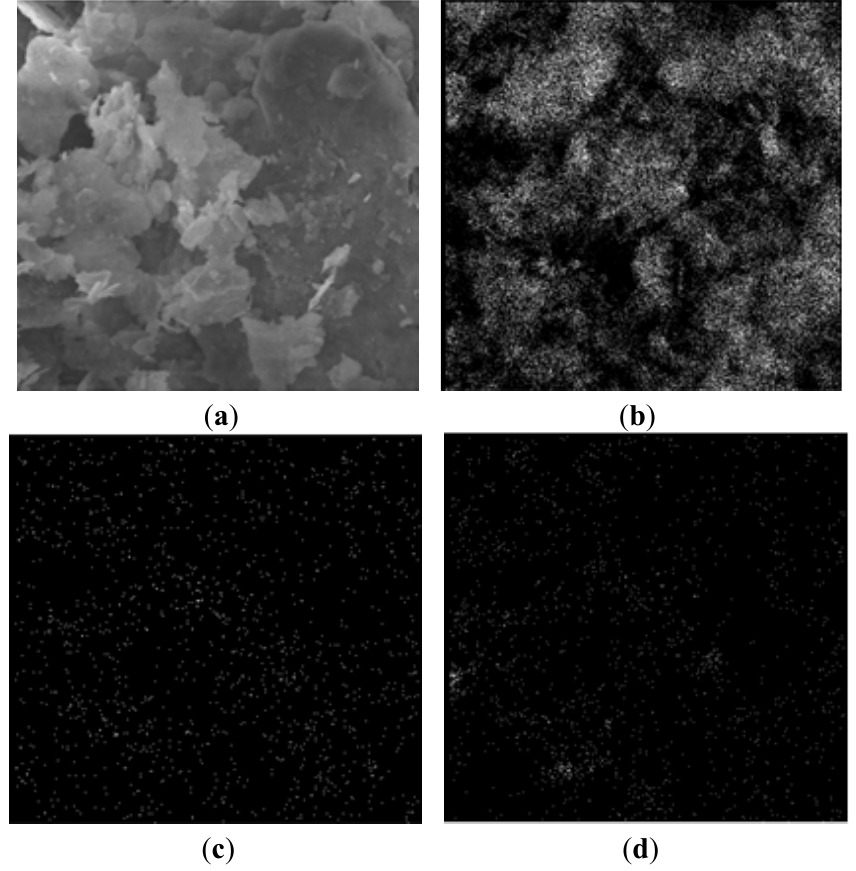
Figure 8. SEM micrographs of Al-1 wt% SiC nanocomposite powder ball milled